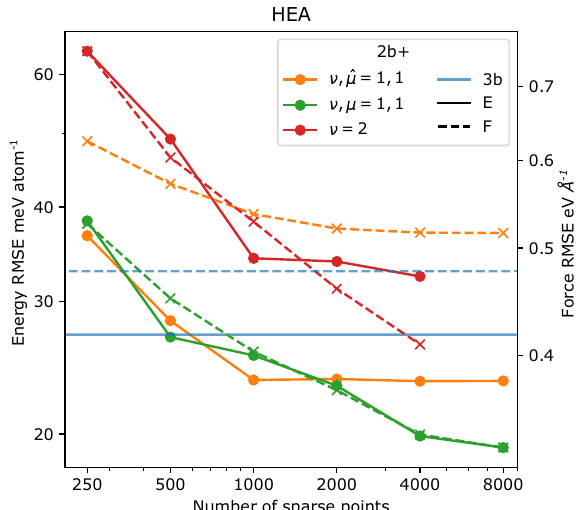
Fig. 8 Model errors on HEA test set. The left hand panel shows how the energy and force errors on the test set change with the number of sparse points. Note that the 2b + 3b model is from ref. 49 where it was reported that increasing the number of sparse points did not improve performance.